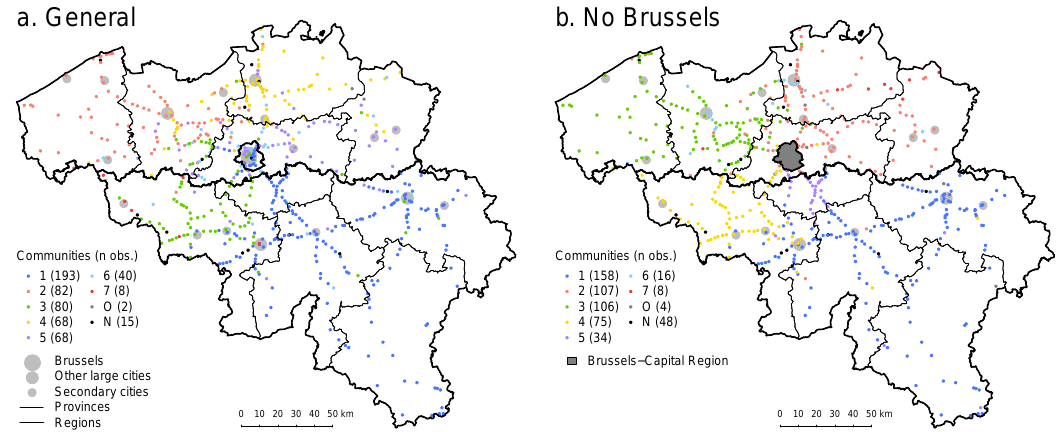
Figure 5. Communities in the iRail dataset for the ( a ) general and ( b ) no Brussels subsets (in the legend: O = other communities, with less than five nodes; N = not present in the